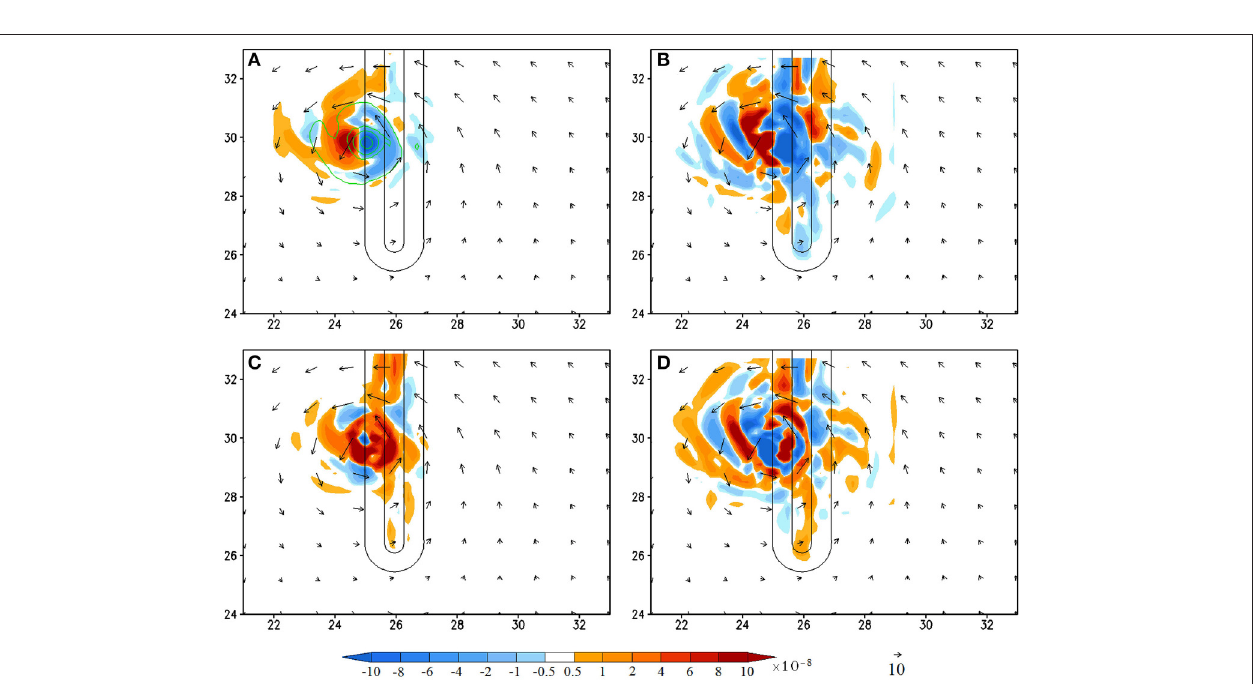
FIGURE 6 | (CNTL/A2) Vorticity budget analysis averaged for the 950–500 hPa layer at 180h (shaded): (A), vorticity tendency (VT); (B), horizontal vorticity advection; (C), relative vorticity stretching, and (D), residual term. The vertical vorticity field is depicted by contours (0.0001, 0.0005, 0.001, 0.002, 0.003 s − 1 ) in (A) . The residual term is obtained by subtracting (A) by the sum of (B,C) , vertical advection, planetary vorticity stretching, and tilting terms. The last three terms are not shown since their magnitudes are negligible compared to terms (A–C) . The units of the coordinates in the x and y directions are 100km.